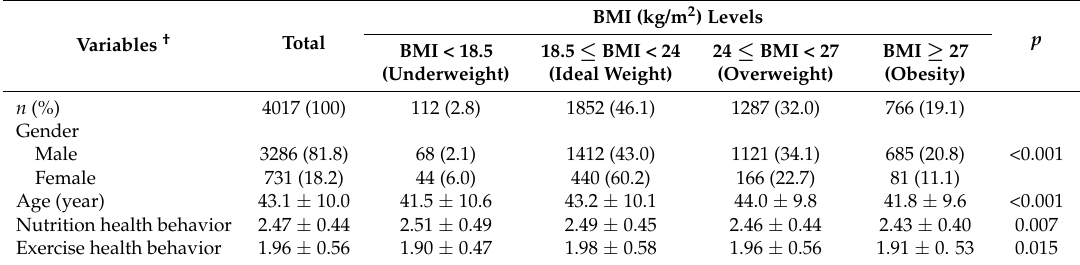
Table 1. Descriptive statistics of the participants’ personal characteristics by BMI levels